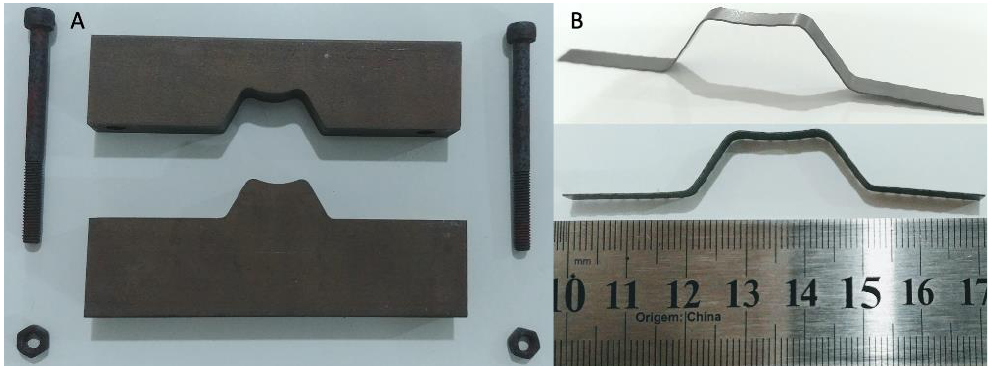
Figure 4. ( A ) Metallic mold used to apply the shape setting process; ( B ) M-Shape device of SMA-SE.